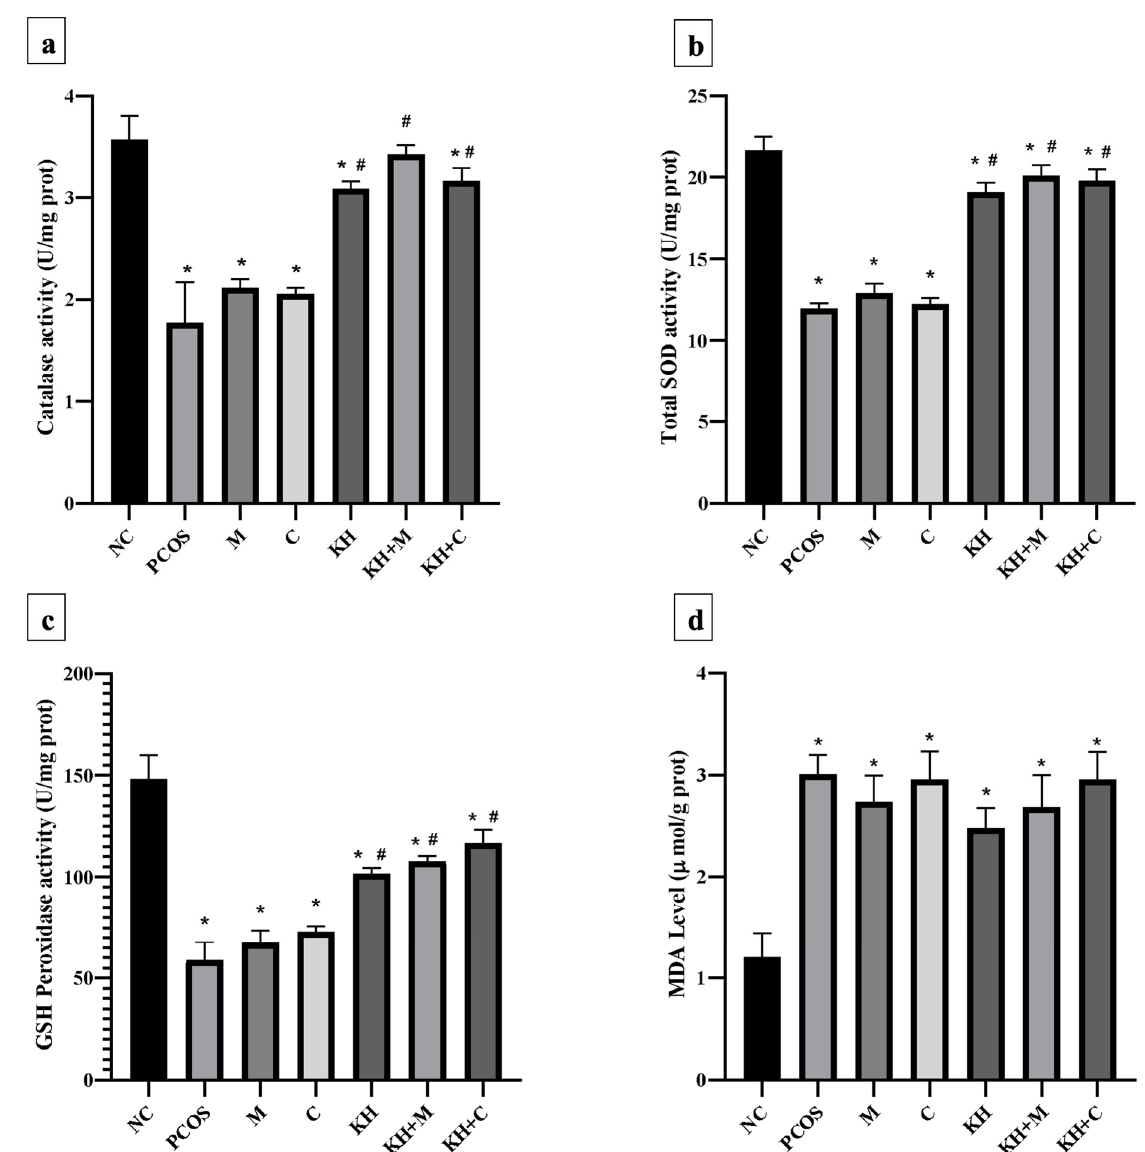
Figure 7. Effects of KH on ovarian ( a ) catalase activity, ( b ) total SOD activity, ( c ) GSH peroxidase activity, and ( d ) MDA levels. NC: normal control; PCOS: Untreated PCOS; M: PCOS + Metformin; C: PCOS + Clomiphene; KH: PCOS + Kelulut honey; KH + M: PCOS + Kelulut honey + Metformin; KH + C: PCOS + Kelulut honey + Clomiphene. * p < 0.05 significance against the normal control group, # p < 0.05 significance against the untreated PCOS group. n = 6 per treatment group.